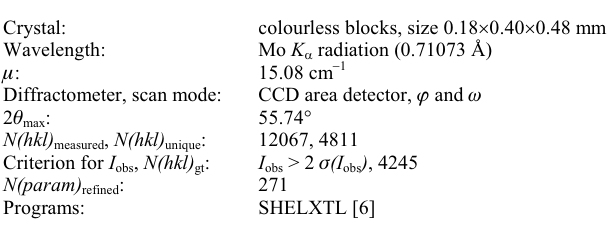
Table 1. Data collection and